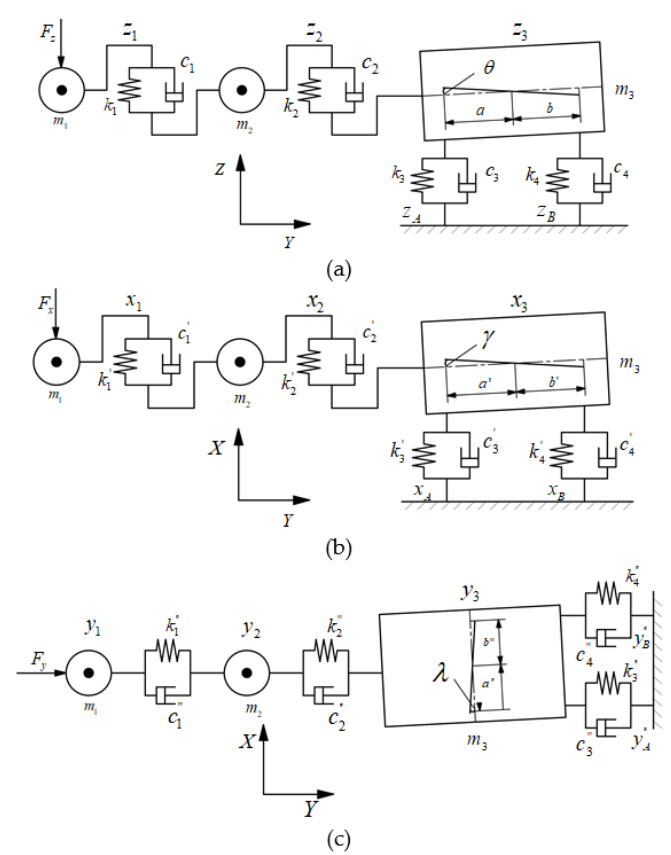
Figure 5. Mechanical model of roadheader. ( a ) Z-direction; ( b ) X-direction; ( c ) Y-direction.